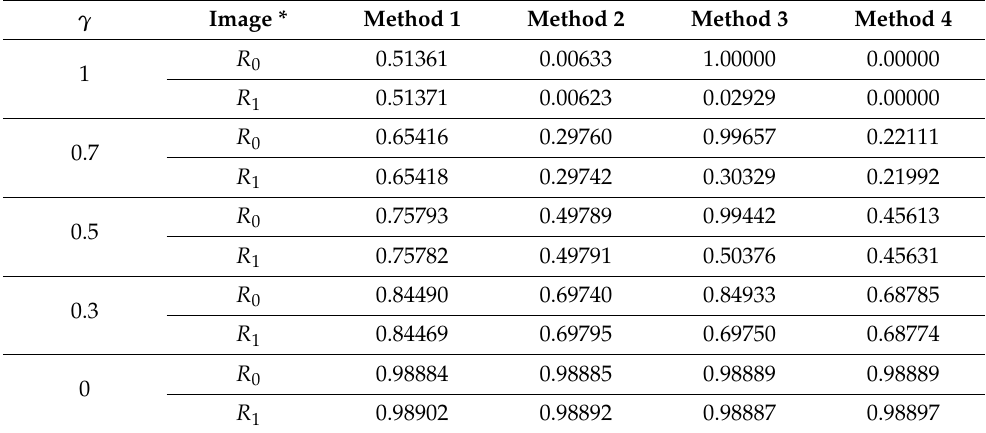
Table 5. The SSIM analysis of our